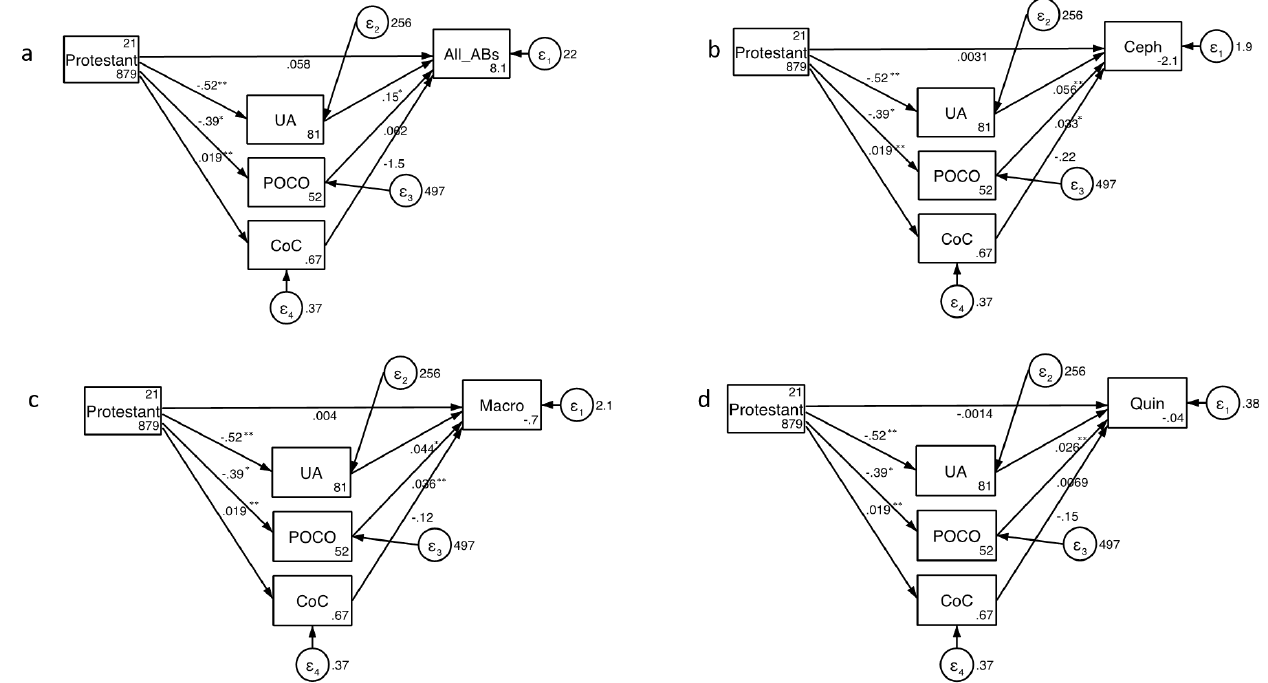
Figure 2. Structural equation modelling of predictors of consumption of total antibacterials ( a ), cephalosporins ( b ), macrolides ( c ) and fluoroquinolones. The numbers next to the arrows are coefficients and their significance is indicated as follows: * P<0.05, ** P<0.005 (Abbreviations: All AB – All Antibacterial consumption; Ceph – Cephalosporins, CoC – Control of Corruption, Macro – Macrolides; POCO – Performance Oriented vs. Cooperation Oriented Index; Quin – Fluoroquinolones; UA - Uncertainty Avoidance